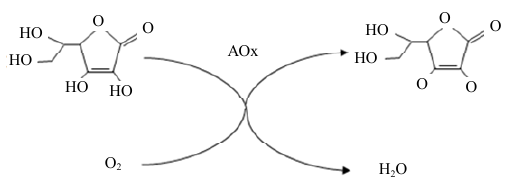
Fig. 19 Reduction of ascorbic acid in the presence of